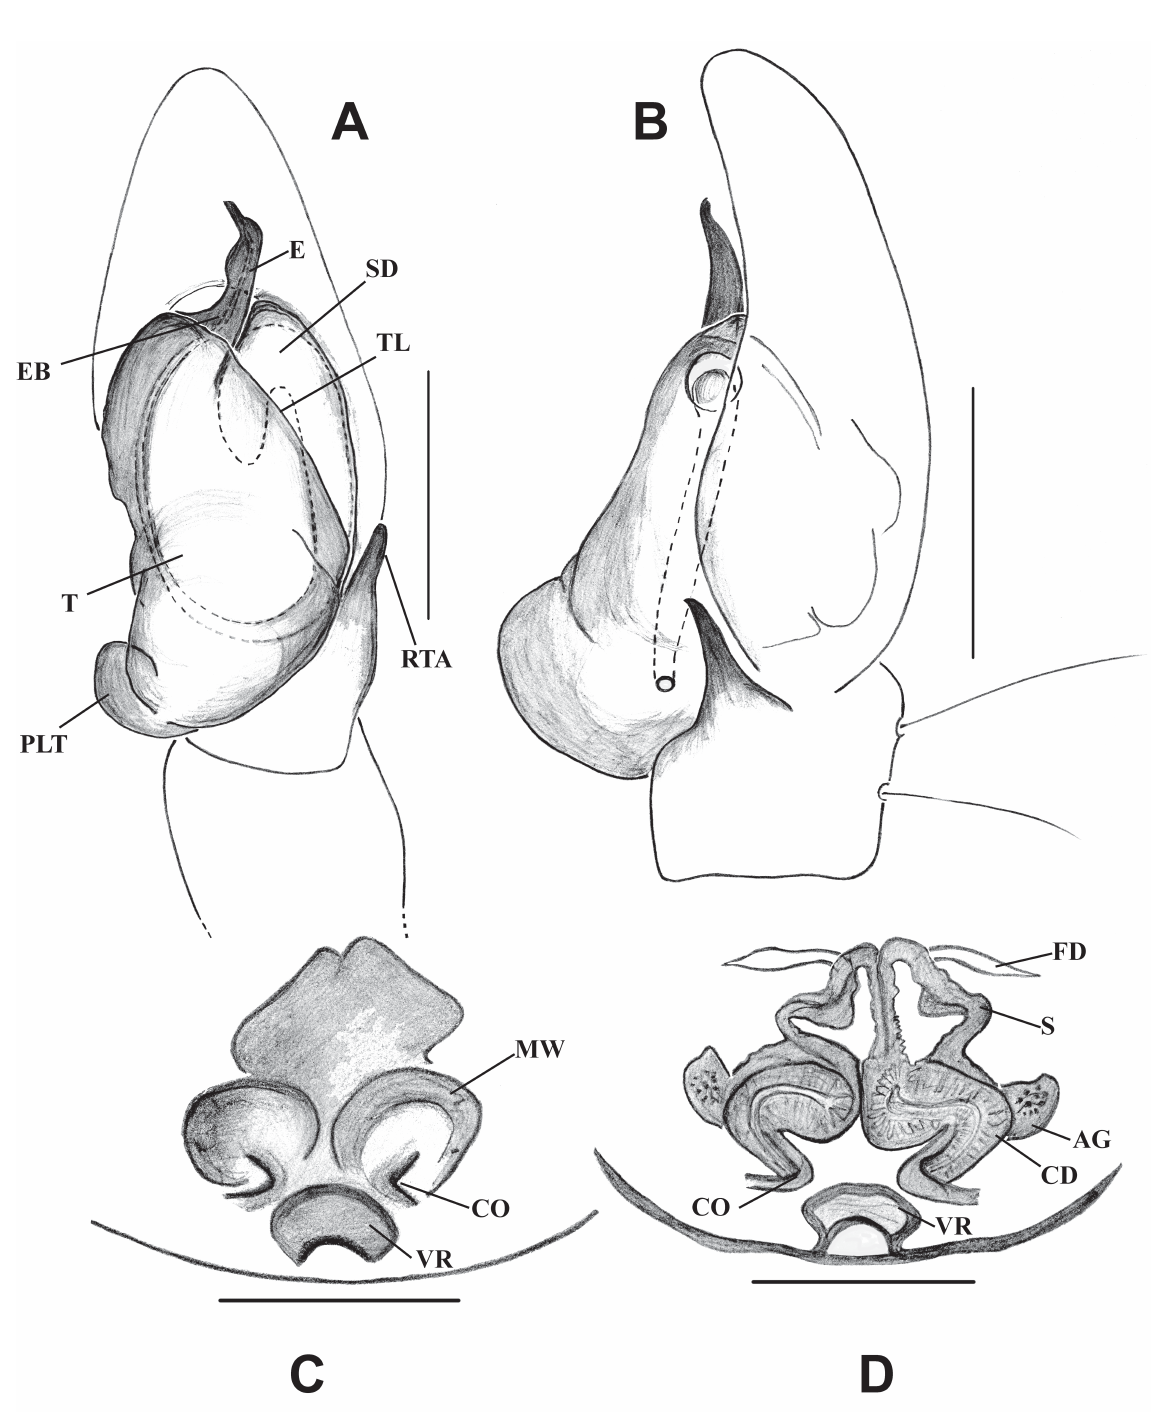
Fig. 8. Habrocestum kodigalaensis sp. nov. A–B . ♂ (IFS_SAL 516 and IFS_SAL 345). C–D . ♀ (IFS_ SAL 467). A . Palp, ventral view. B . Palp, retrolateral view. C . Epigyne, ventral view. D . Vulva, ventral view. Abbreviations: AG = accessory gland; CD = copulatory duct; CO = copulatory opening; E = embolus; EB = embolic base; FD = fertilization duct; MW = membranous window; S = spermathecae; SD = sperm duct; T = tegulum; TL = tegular ledge; PLT = proximal lobe of tegulum; RTA = retrolateral tibial apophysis; VR = vaginal roof. Scale bars: A–B = 0.2 mm; C–D = 0.1